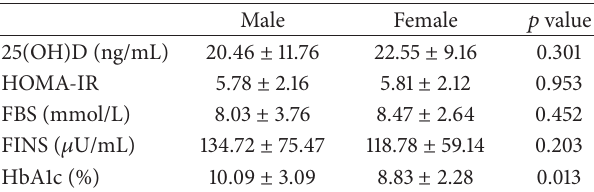
Table 3: Comparison of male and female of 25(OH)D, glucose metabolism indices (FBS, FINS, and HbA1c), and HOMA-IR. Male Female 𝑝 value 25(OH)D (ng/mL)